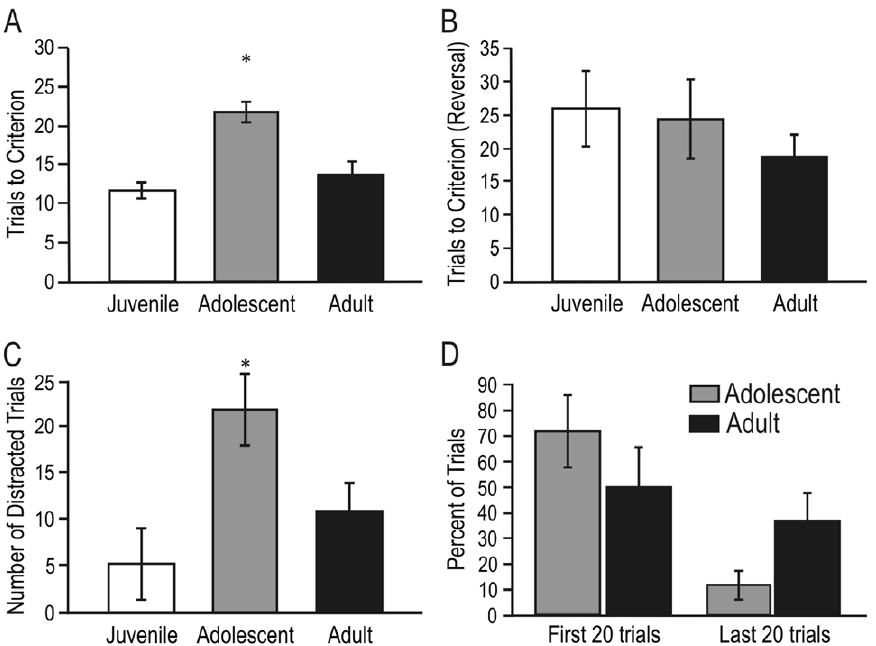
Figure 1. Adolescent rats learn an odor-guided association more slowly than juvenile or adult rats. A) Average number of trials ( 6 SE) to reach criterion (8 out of 10 consecutive trials correct) on an olfactory-guided associative learning task. Adolescent rats required significantly more trials to learn the odor association than either juvenile or adult rats (*, p , 0.002 and p , 0.02, respectively) B) Average number of trials ( 6 SE) to reach criterion on the reversal task. There were no differences between groups on this task; however, juvenile and adult rats took longer to reach criterion on reversal than on the initial odor association task (compare with panel A ). C) Average number of trials ( 6 SE) that rats displayed ‘‘distracted’’ behavior not directed at the sand-filled cups (e.g., grooming, exploration). These trials were not included in the data shown in panel A . While juvenile rats were rarely distracted, adolescent rats displayed significantly more distracted trials than either adult or juvenile animals (*, p , 0.05 and p , 0.02, respectively). The average number of distracted trials exhibited by adult rats was not significantly different from juvenile animals. D) In adolescent rats, distractibility decreased over the course of the learning task; distracted trials in adolescent rats were significantly more prevalent in the first 20 trials of the odor association task than in the 20 trials immediately prior to criterion. No such change in distractibility was seen in adult animals across the duration of the task.